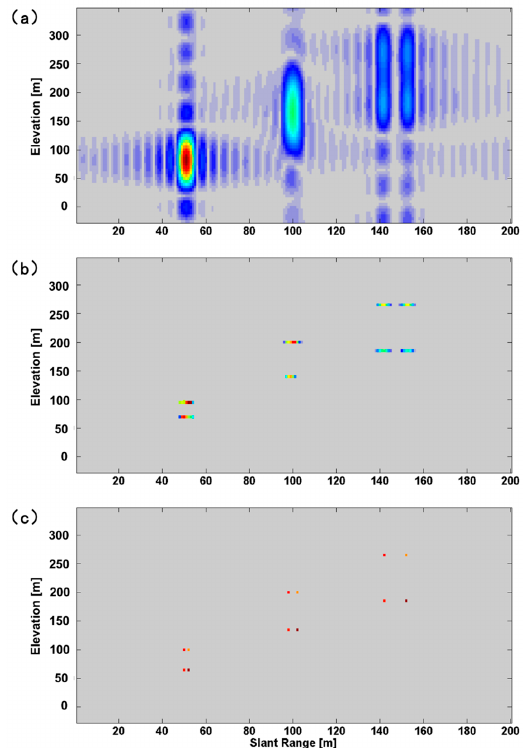
Figure 7. Reconstruction signal in the range-elevation plane: ( a ) Fourier Beamforming; ( b ) CS 1D TomoSAR method; and ( c ) CS-2D-TomoSAR method.